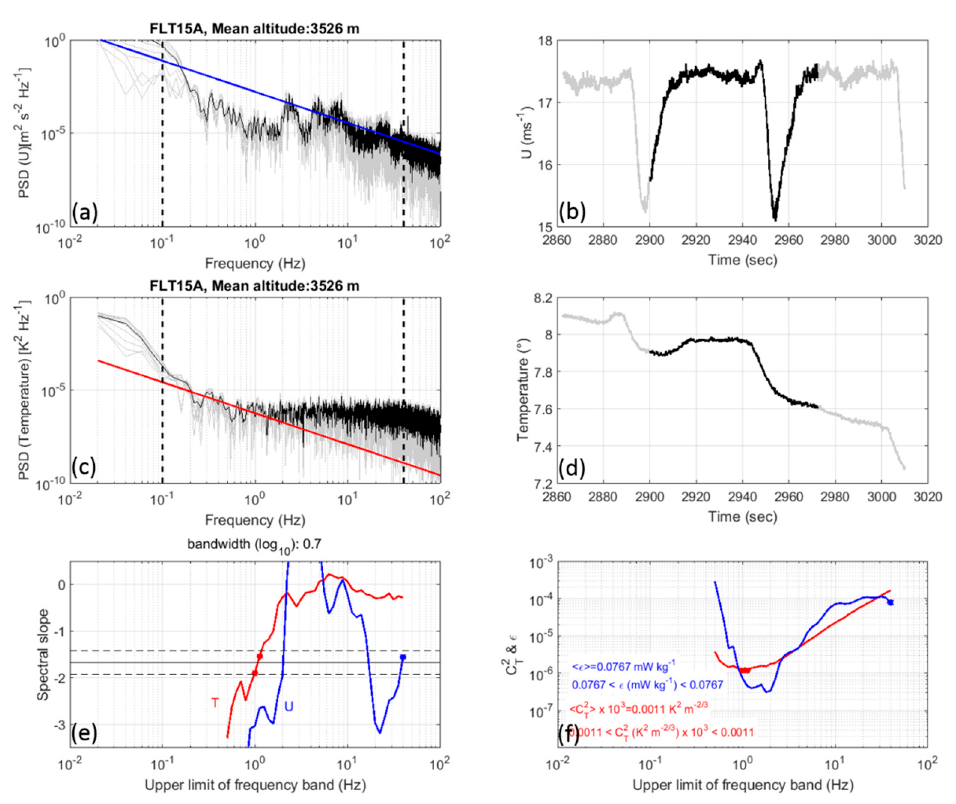
Figure 4. The same as Figure 2 for a case with strong disturbances in U spectra during FLT15A around 3526 m altitude.